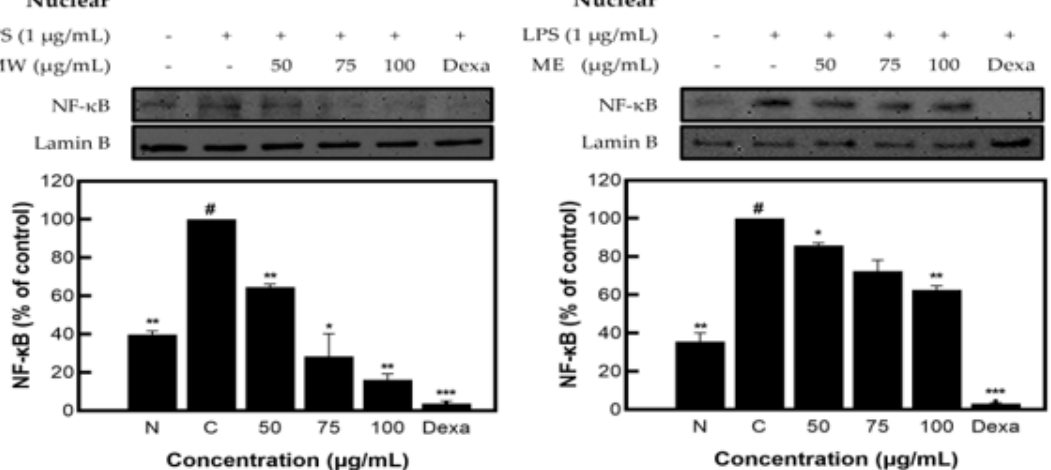
Figure 5. NF- κ B protein expression rate of M. pruriens extract on macrophage cell (RAW 264.7).